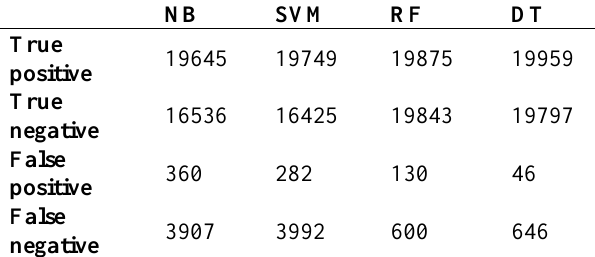
Table 12. Experiment with 18 Attributes.